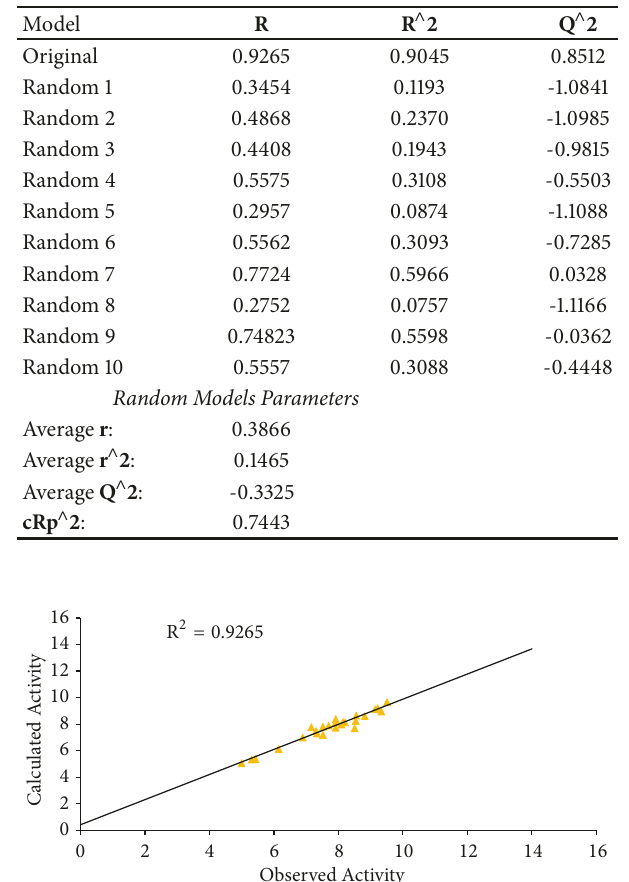
Table 7: Y-randomization parameters test.